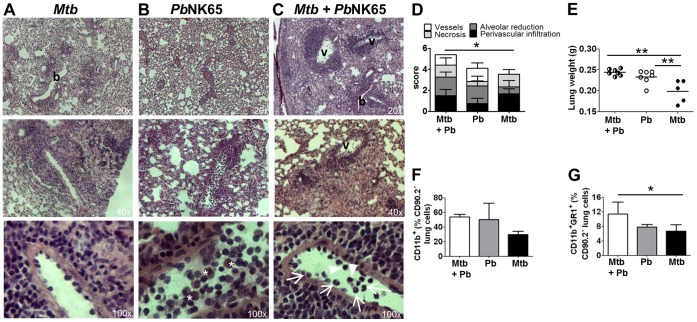
Malaria co-infection increases inflammatory tissue responses in M. tuberculosis infected lungs.C57BL/6 mice were aerosol infected with M. tuberculosis H37Rv (100 CFU/lung) and 40 days later challenged with PbNK65 sporozoites by mosquito bite. Control mice were infected with M. tuberculosis or PbNK65 alone, respectively. A–C) Representative H&E stains of lungs 13 days after co-infection. Note, that PbNK65 co-infection exacerbated tissue pathology compared to lungs of mice infected with M. tuberculosis alone (v  =  vessel, b  =  bronchus; asterisks indicate hemozoin loaded cells; arrow: neutrophils; arrowhead: monocytes). D) Histopathological scores from co-infected, PbNK65 or M. tuberculosis infected lungs are shown. Pathology was most severe in co-infected animals, with the total score being significantly increased compared to M. tuberculosis infected lungs (n = 4 for co-infected and PbNK65 infected; n = 5 for M. tuberculosis infected). E) Lung weights 12 days after co-infection. F–G) Lung leukocytes were analyzed for surface expression of CD11b and GR-1. Results are shown as means ± SD (n = 3–5). Results from one representative experiment out of two independent ones are shown. Statistical analysis was performed by ANOVA (*p<0.05; **p<0.01).